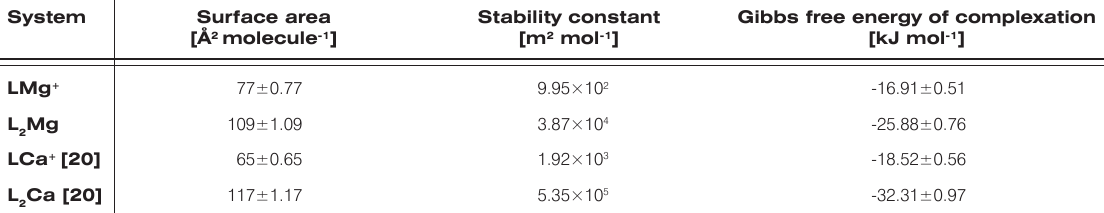
Figure 4. Schematic representation of phosphatidylcholine monolayer with magnesium ions (LMg + and L Table 1. Physicochemical parameters for 1:1 and 1:2 lecithin-divalent ion complexes.